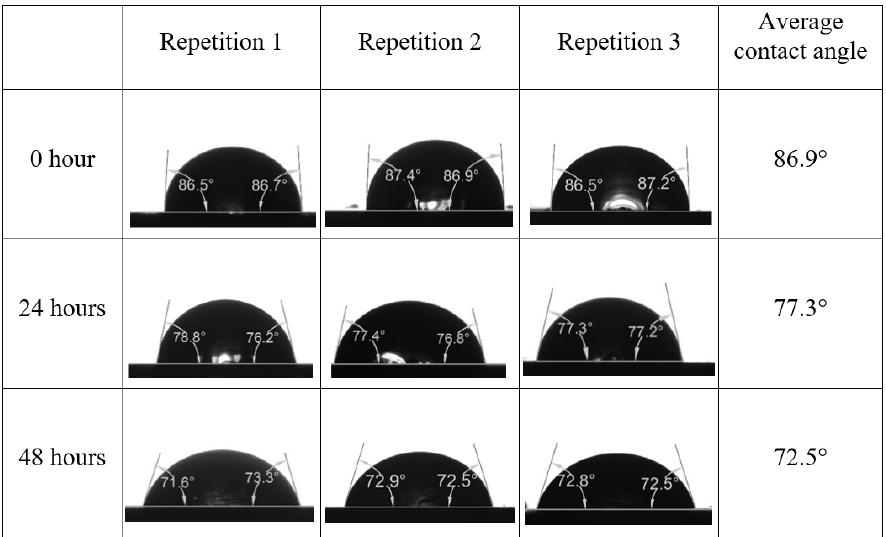
Figure A2. Dynamic Contact Angle Measurement Results for 20-times Diluted Sea-water (1750